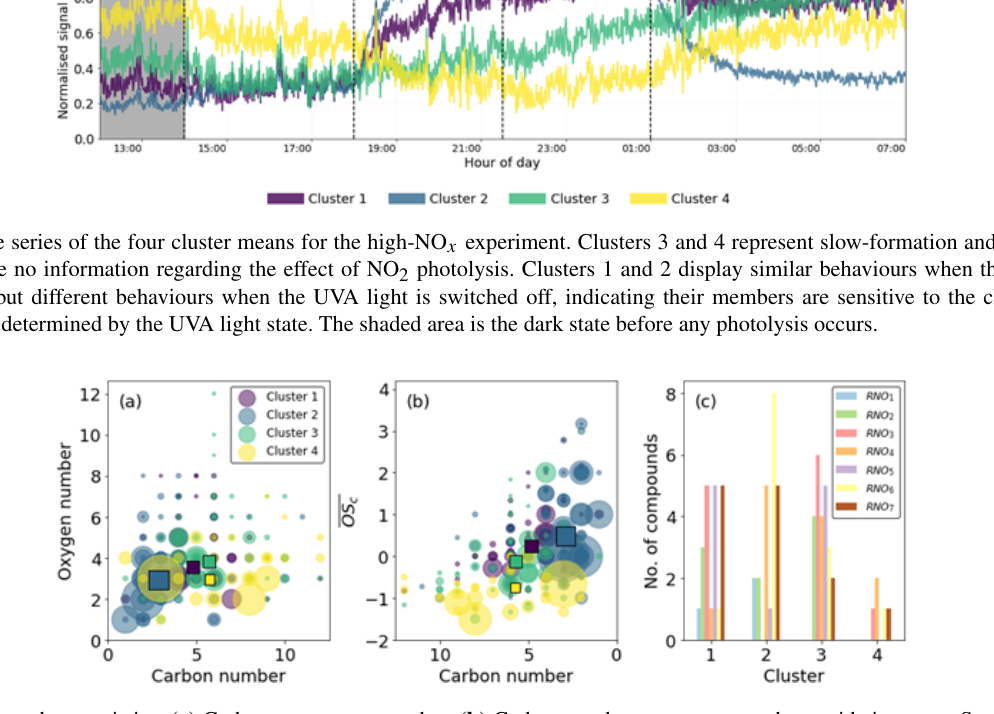
Figure 13. Cluster characteristics. (a) Carbon vs. oxygen number. (b) Carbon number vs. average carbon oxidation state. Squares indicate cluster averages. (c) Number of RNO x species. Clustering based on time series similarity provides good separation in OS C vs. C space (b) and splits RNO odd and RNO even in clusters 1 and 2 (c)